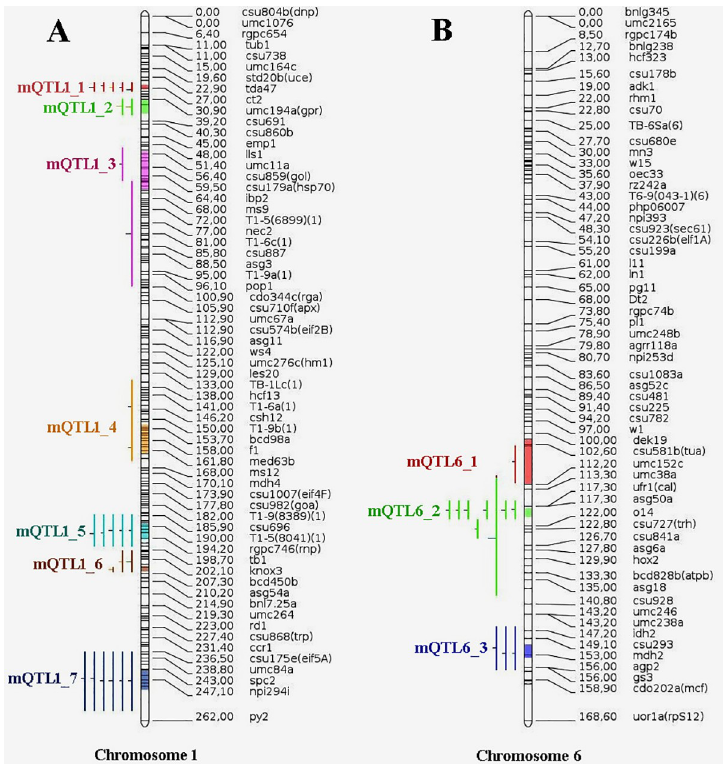
Fig 3. Distribution of Ten metaQTLs for popping traits on chromosome 1 and 6. (A) Seven metaQTLs, viz ., mQTL1_1, mQTL1_2, mQTL1_3, mQTL1_4, mQTL1_5, mQTL1_6 and mQTL1_7 identified on chromosome 1 with an average number of markers of 25.75 and average marker interval distance of 13.70 cM. (B) Three metaQTLs, viz ., mQTL6_1, mQTL6_2, mQTL6_3 were identified on chromosome 6 having the corresponding values for marker number and interval were 16.40 and 15.97cM,